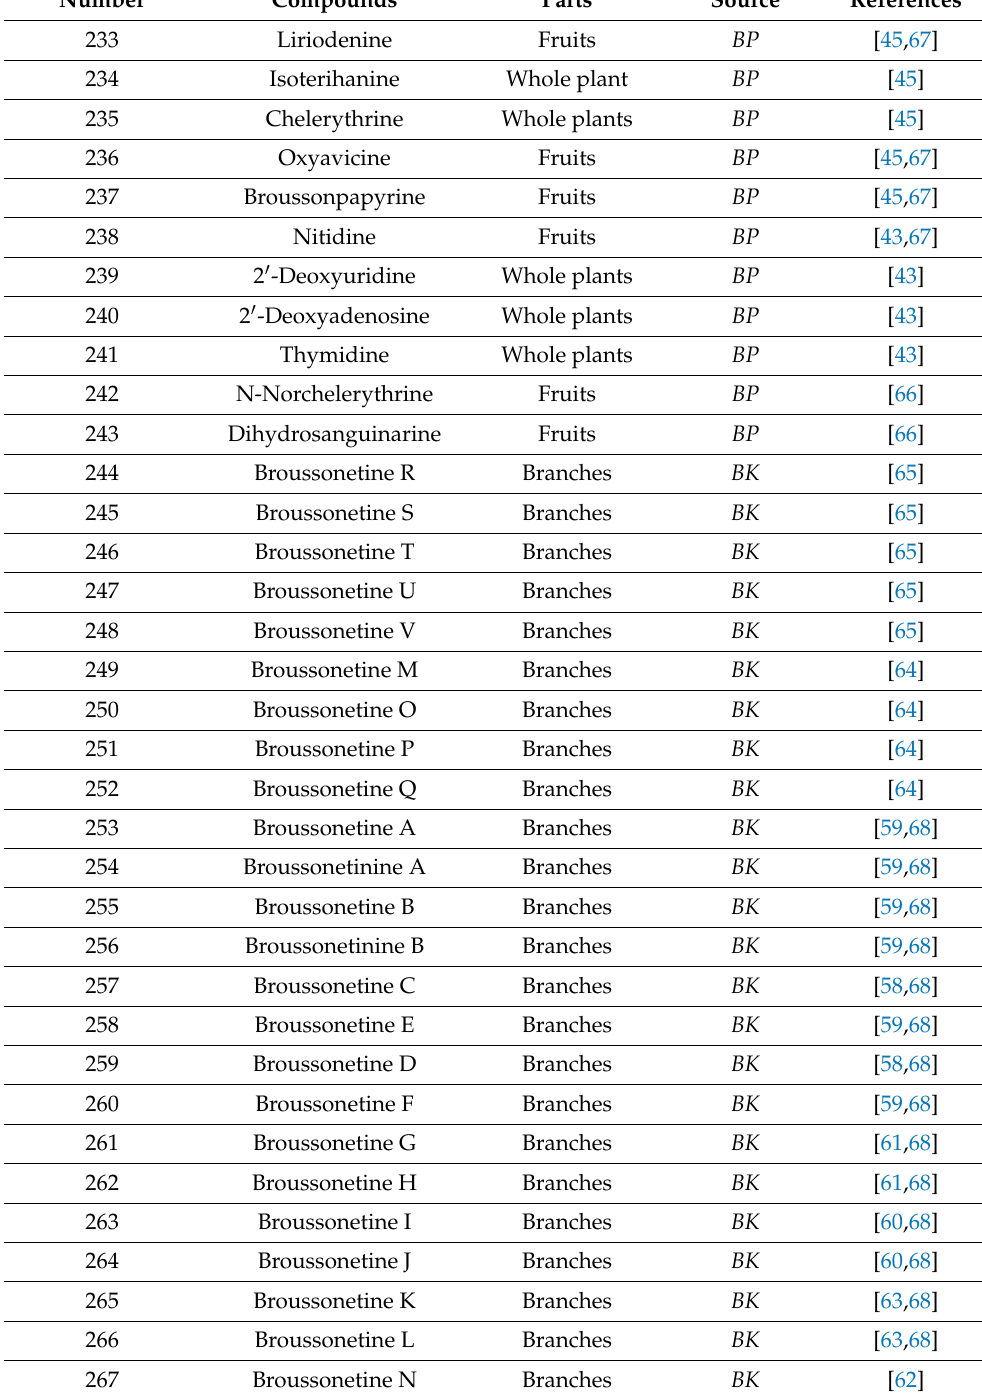
Table 4. Alkaloids isolated from Broussonetia